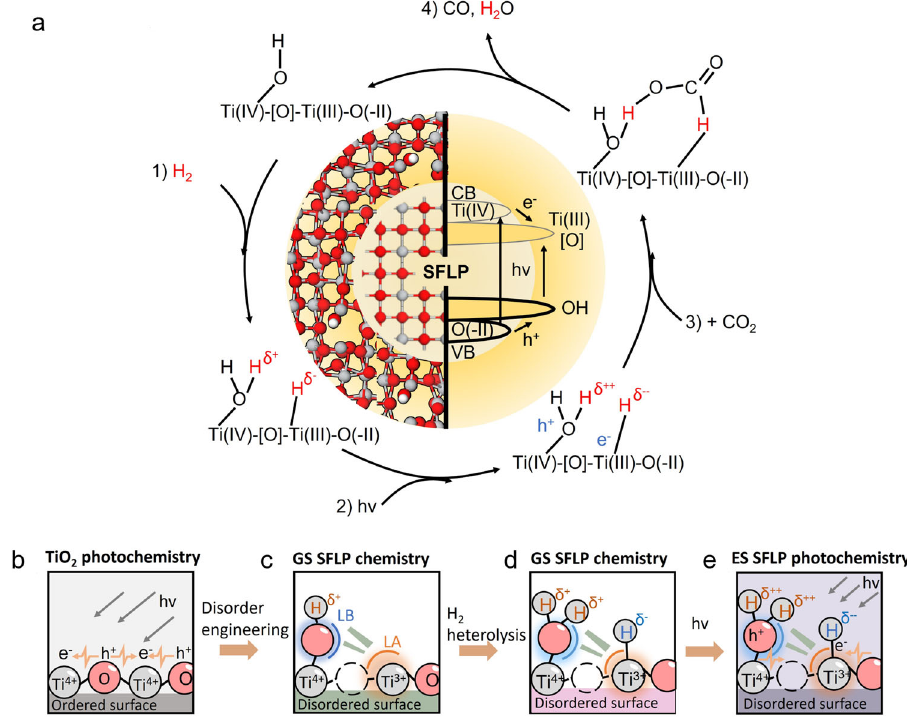
Fig. 1 | SFLPs, con fi ned to the surface of the amorphous shell of the c-TiO 2 @a-